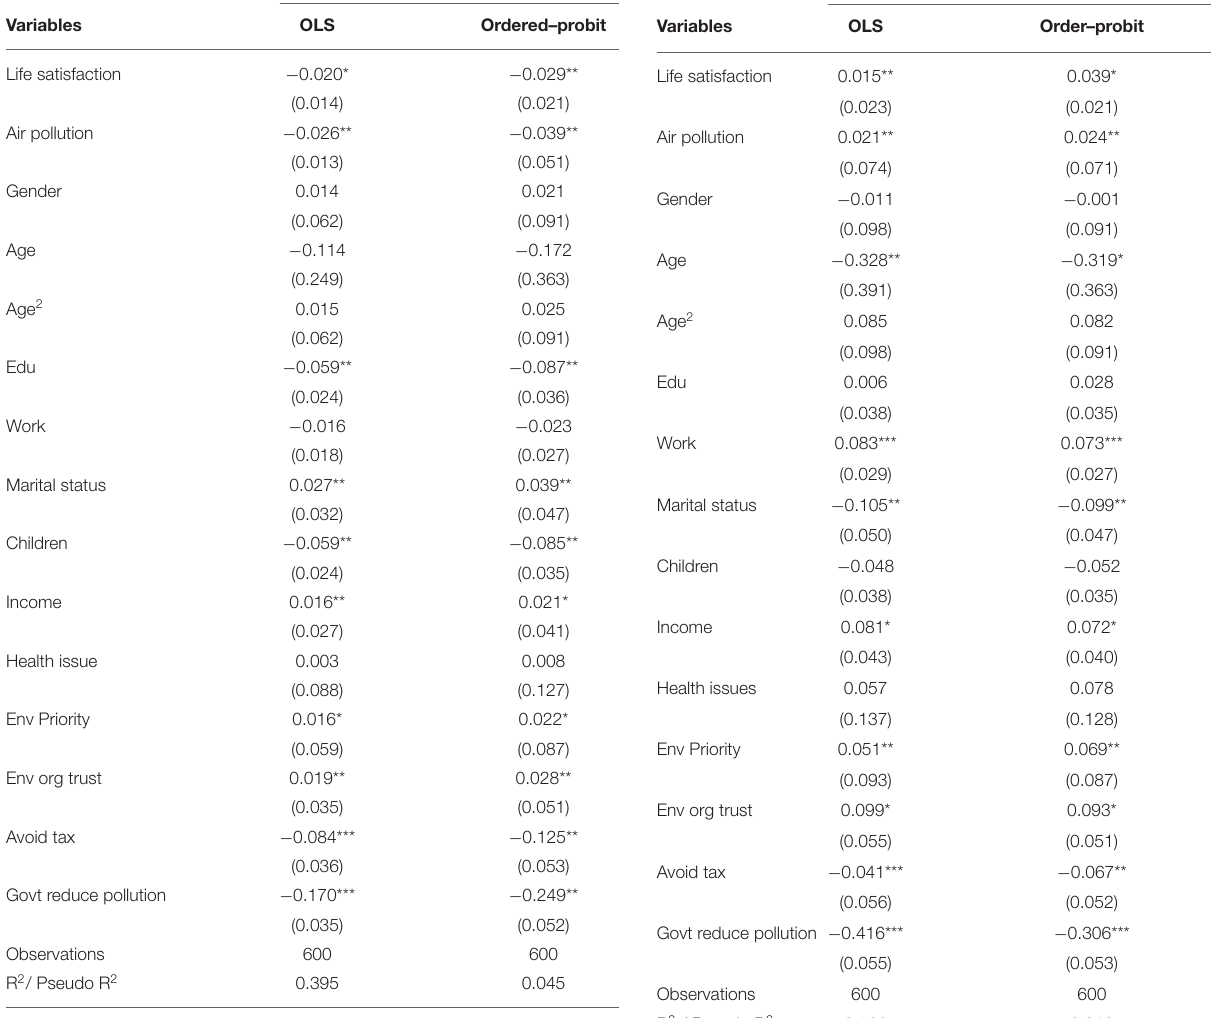
TABLE 3 | Determinants of the social payment for pollution prevention. TABLE 2 | Determinants of the tax payment for pollution prevention. Dependent variable: envtax Dependent variable: income contribution